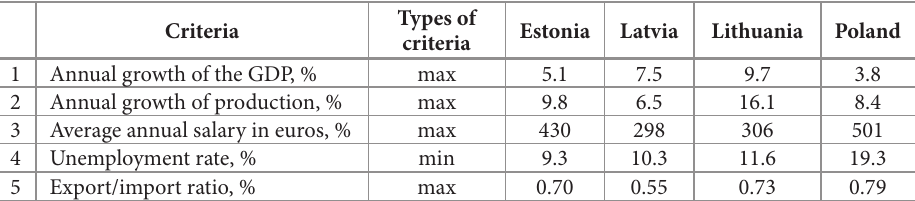
Table 1. Criteria values of economical growth of different